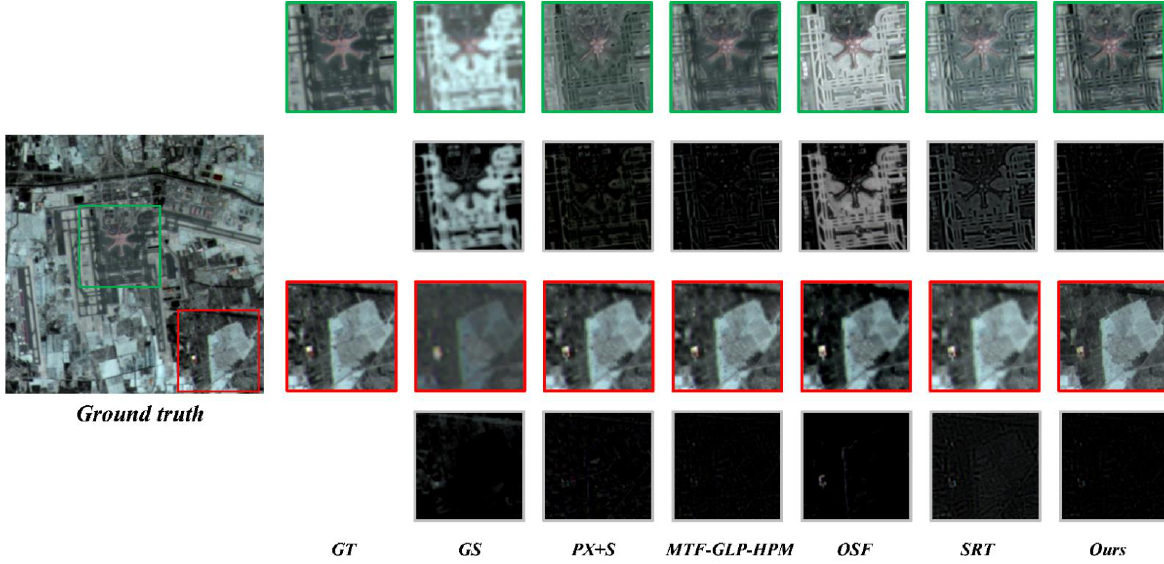
Figure 3. Comparison of fusion results of different algorithms on simulation data (the original image was taken in Beijing on 3 May 2022; scene: residential area).